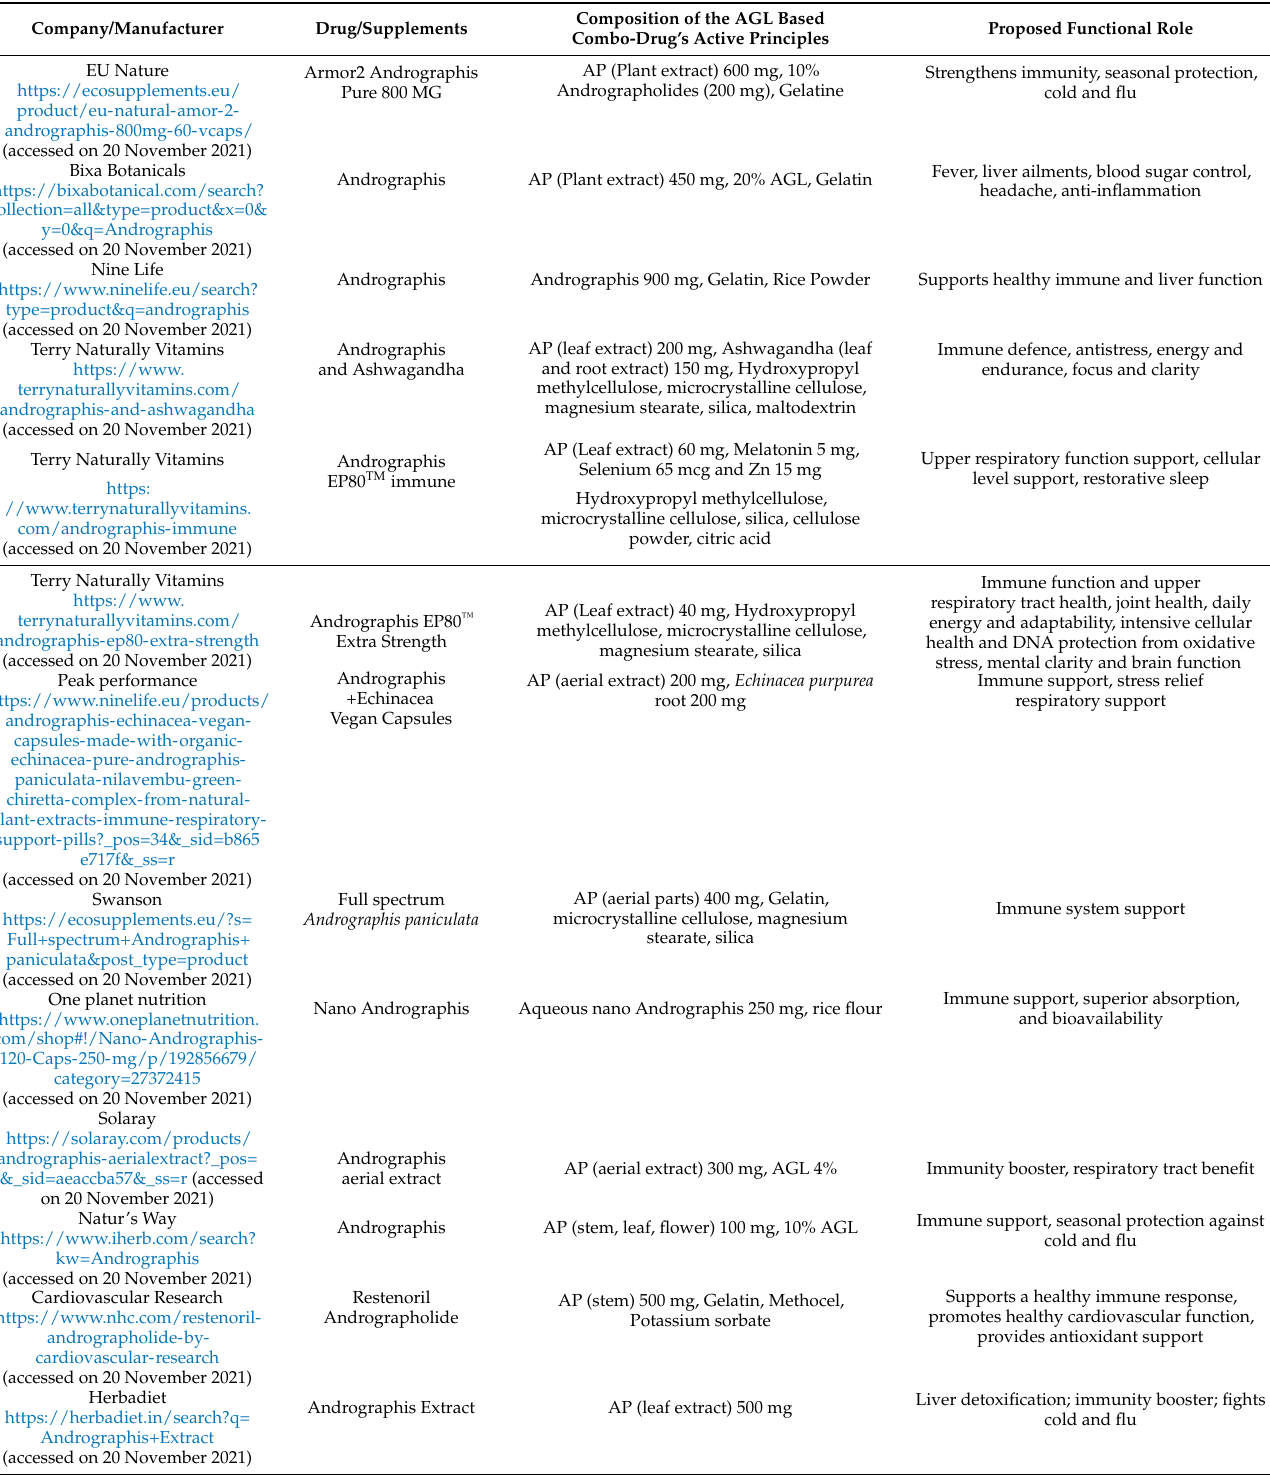
Table 3. Bioactive extract of Andrographis paniculate (AP), its active principles from different commercial sources and their proposed functions on human